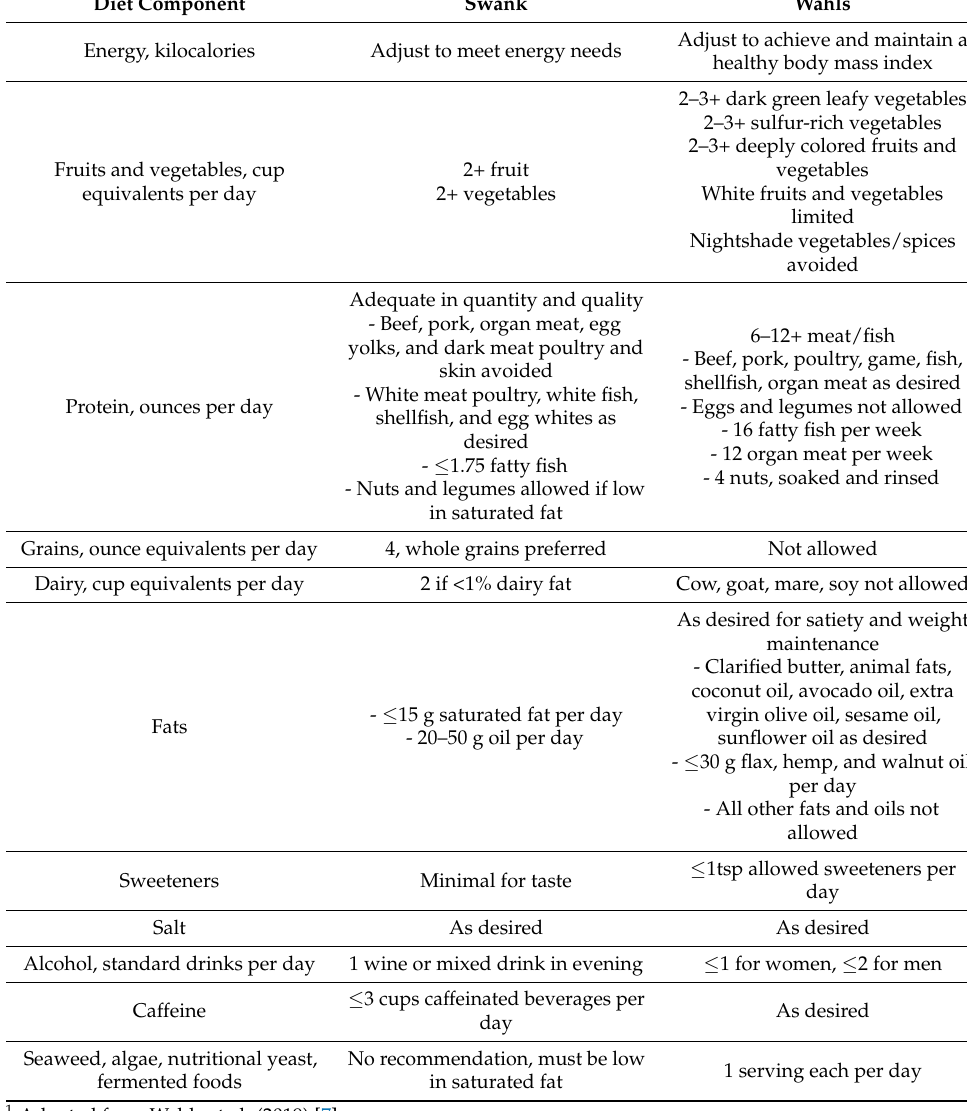
Table 2. Description of the low-saturated fat (Swank) and modified Paleolithic elimination (Wahls) diets 1